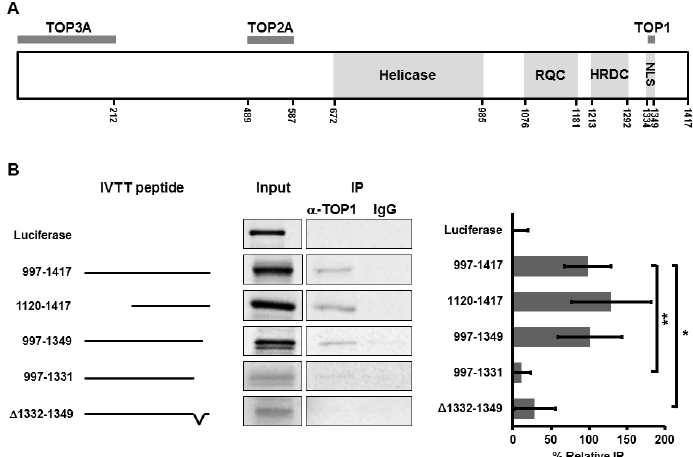
Figure 1. BLM amino acids 1332–1349 are required for binding to topoisomerase I. ( A ) Diagram of the full-length BLM protein (1417 amino acids) highlighting known functional domains and the interaction regions with topoisomerase I (TOP1), topoisomerase II α (TOP2A) and topoisomerase III α (TOP3A). An additional TOP3A-interaction region consisting of amino acids 1266–1417 was reported in one study [56]; ( B ) 35 S-methionine-labeled BLM peptide fragments of the indicated amino acids were generated using IVTT, incubated with purified TOP1 and immunoprecipitated using α -TOP1 or isotype control antibodies with Dynabeads Protein G. The C-terminus of BLM (amino acids 997–1417) was used as a positive control and luciferase as a negative control for each replicate. Pulldown of each peptide fragment was quantified and non-specific pulldown subtracted. Each fragment was normalized to its input and expressed as % relative IP compared to the positive control (amino acids 997–1417). Results from 3–9 experiments per peptide were compared to the positive control 997–1417 fragment using a Student’s t -test. A representative gel is shown for each. Error bars depict standard